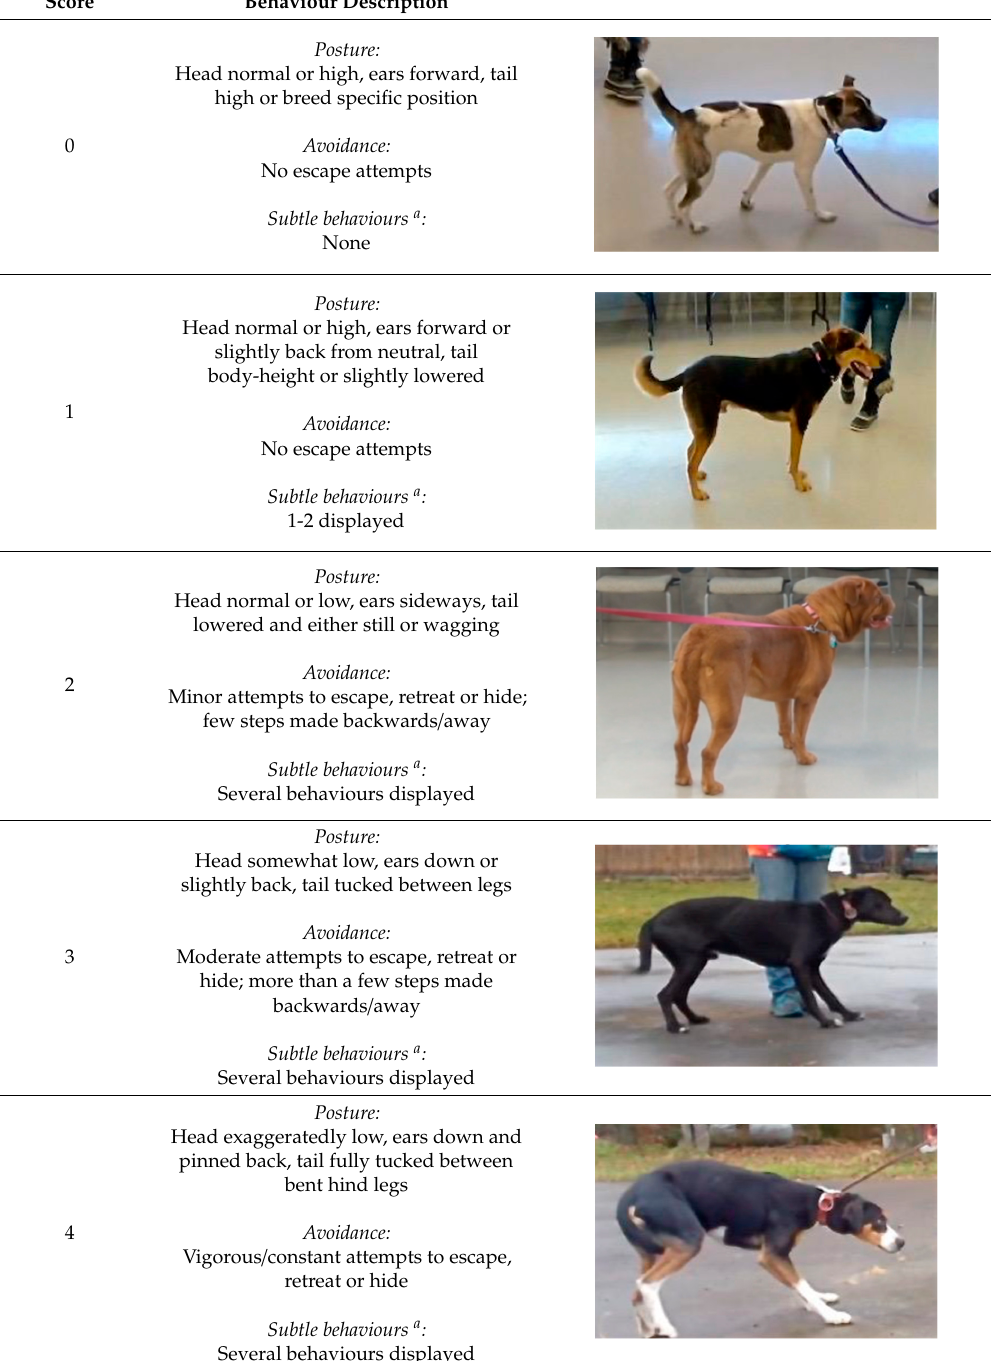
a Subtle behaviours include: yawning, lip licking, body shaking, vocalizing,